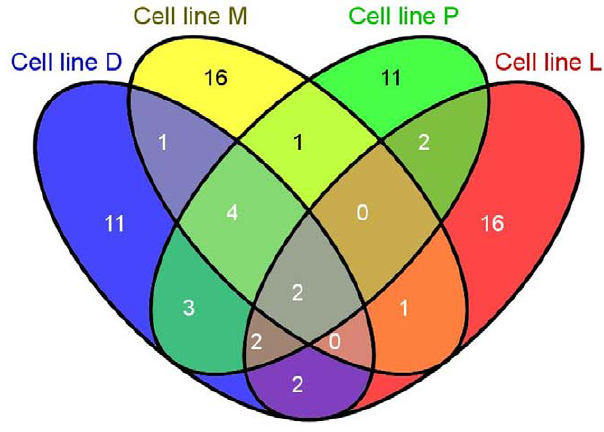
Figure 4. Identification of top 25 commonly regulated micro- RNAs in the four cell types tested. As seen in this venn diagram two miRs are commonly regulated in all four cell types. While 6 miRs were commonly regulated in 3 of the 4 cell types tested, 11 miRs were found to be common in at least 2 of the 4 cell types. Cell-type specific miR regulation was found to be 11 miRs each for PBL and DU145 cell lines and 16 miRs each were regulated in LNCaP and MDM cells.